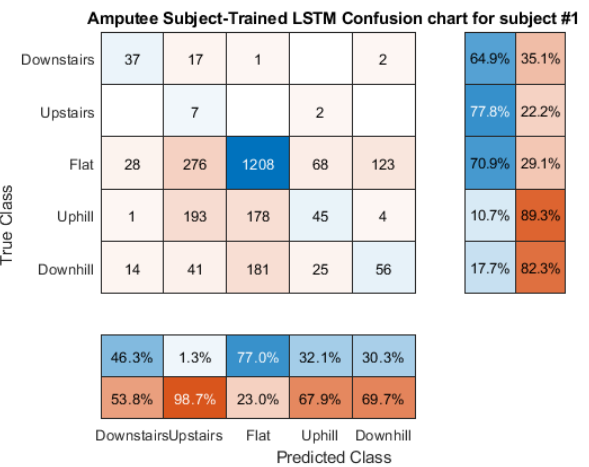
Figure A19. Long Short-Term Memory Network Confusion Chart for ILLA participant A1 as trained by all other ILLA participants.